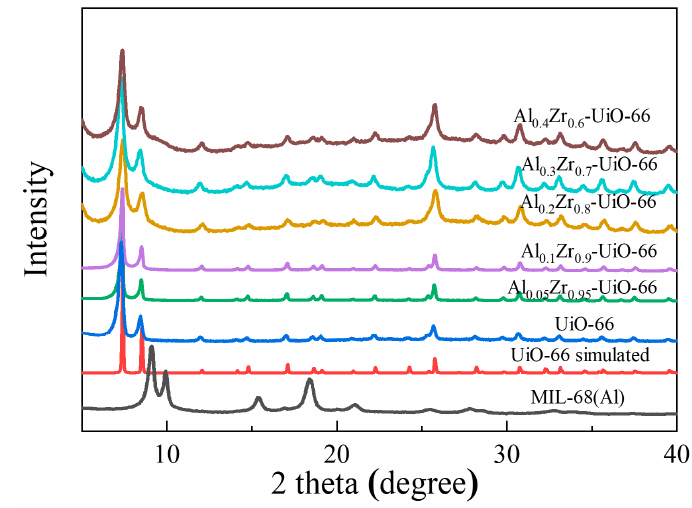
Figure 1. Comparison of the experimental and simulated XRD patterns.